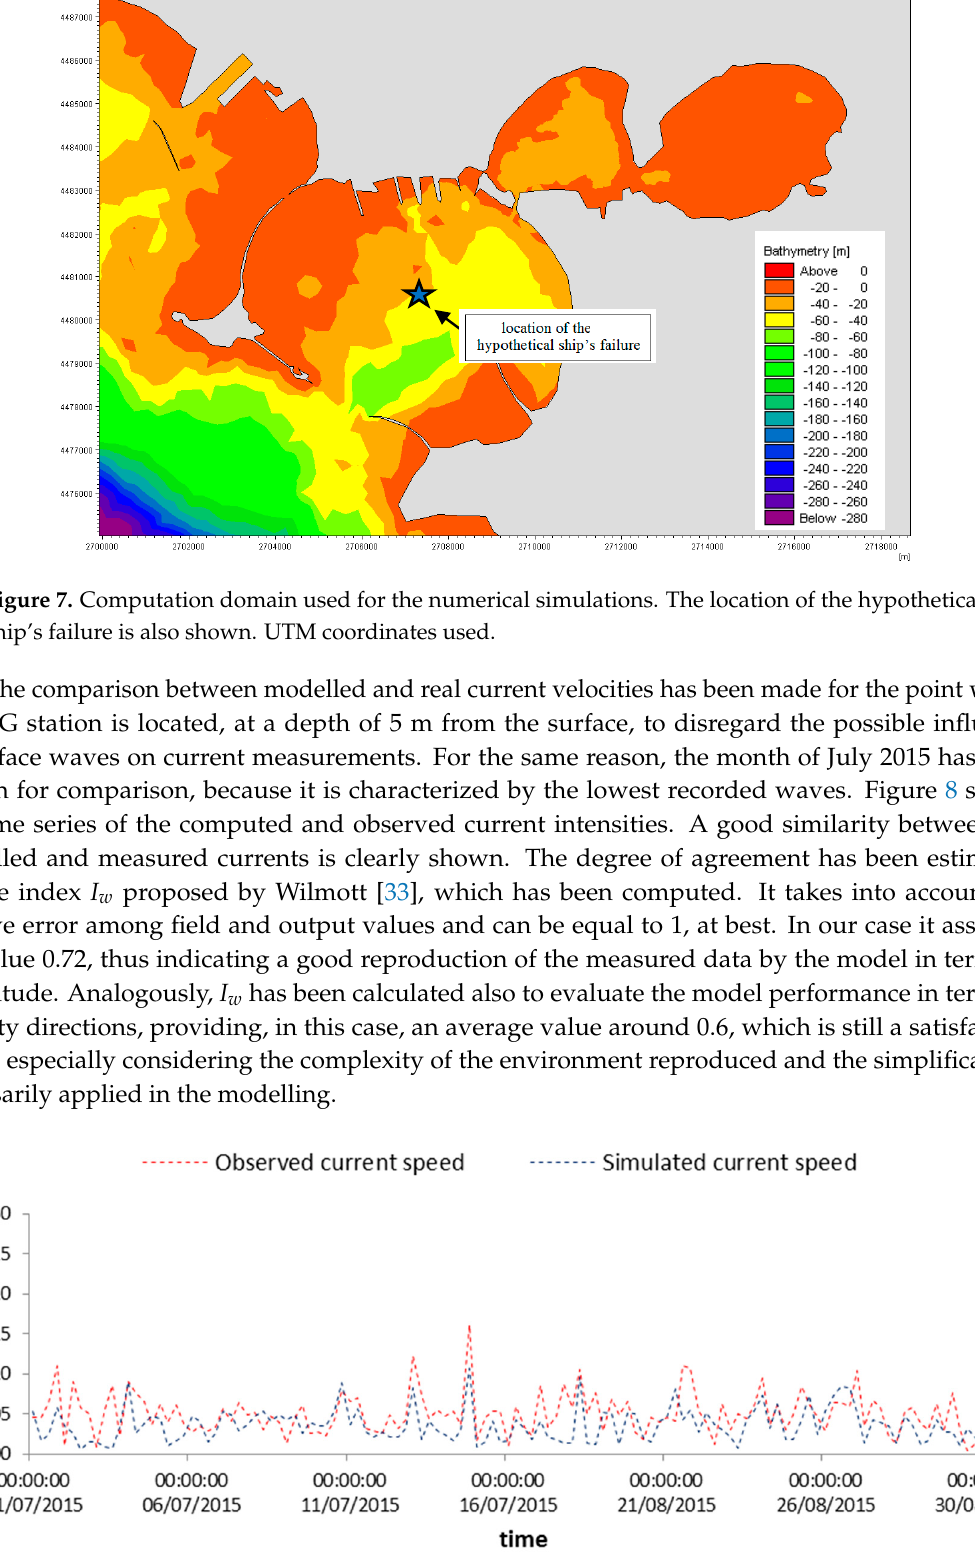
Figure 8. Comparison between time series of observed and simulated current speed at the selected point